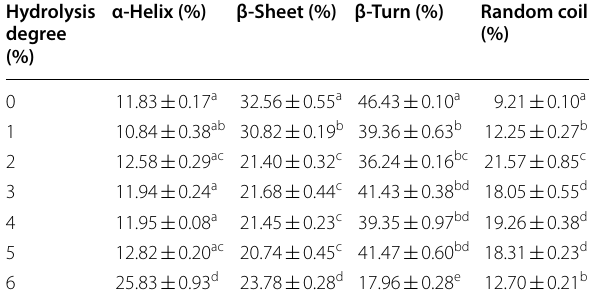
Table 2 Secondary structure content of SPH